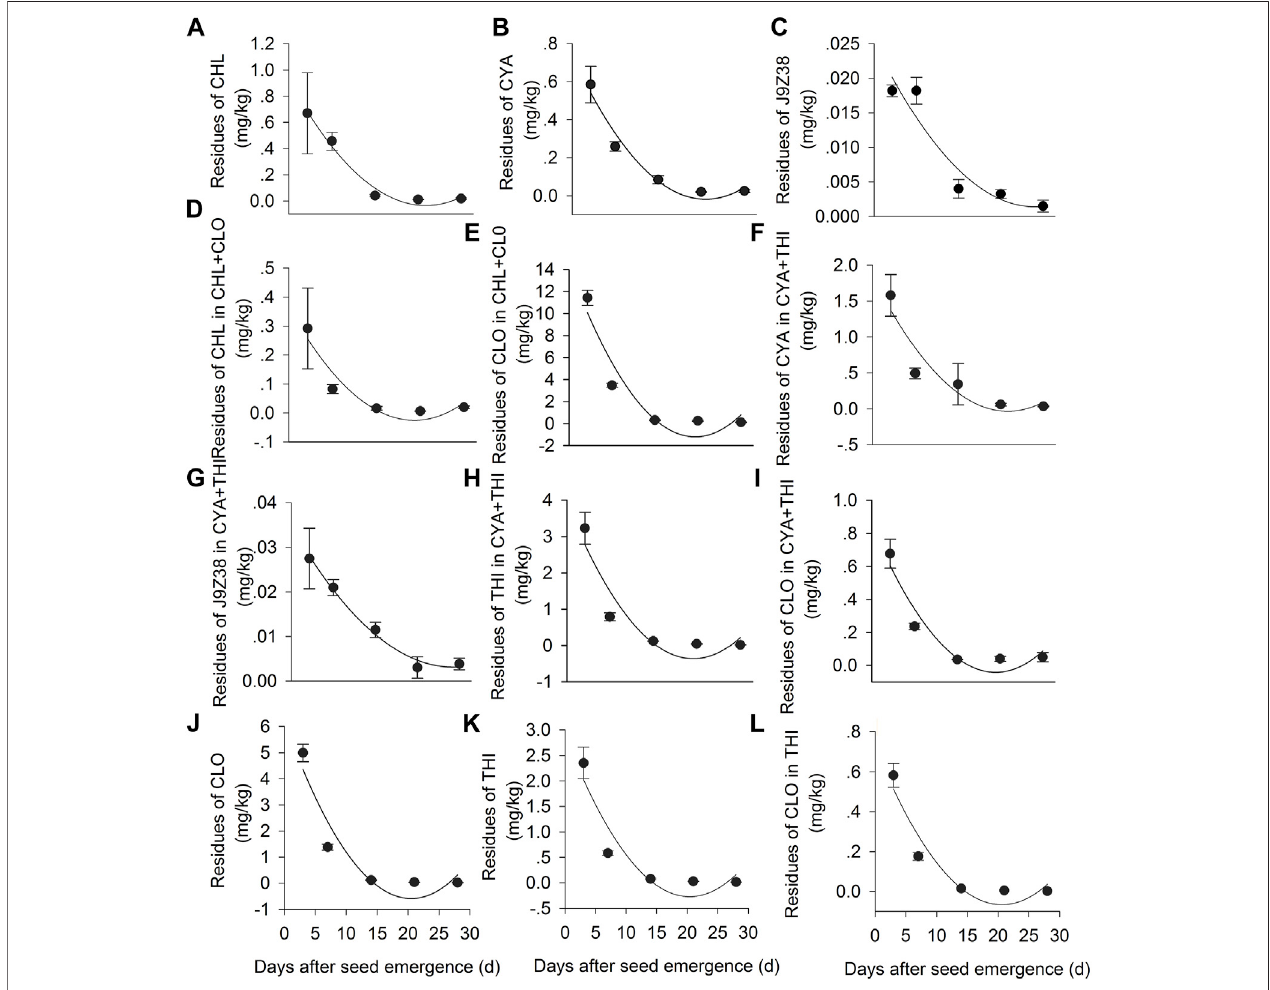
FIGURE5| DynamicchangesintheconcentrationsofinsecticidesandtheirmetabolitesinCHL,CYA,CHL+CLO,CYA+THI,CLO,THItreatedleavesinJulycorn plants.Panels: (A) CHLresidueinCHLtreatedleaves; (B) CYAresiduesinCYAtreatedleaves; (C) J9Z38residuesinCYAtreatedleaves; (D) CHLresiduesinCHL+CLO treated leaves; (E) CLO residues in CHL + CLO treatedleaves; (F) CYA residues in CYA + THI treated leaves; (G) J9Z38 residues in CYA + THI treatedleaves; (H) THI residuesinCYA+THI treatedleaves; (I) CLOresidue inCYA+THItreated leaves; (J) CLOresidueinCLOtreatedleaves; (K) THIresiduesinTHI treatedleaves; (L) CLO residues in THI treated leaves. Fitted regression lines are from the equation C t = C 0 e − bt , and showed in Supplementary Table S2 .